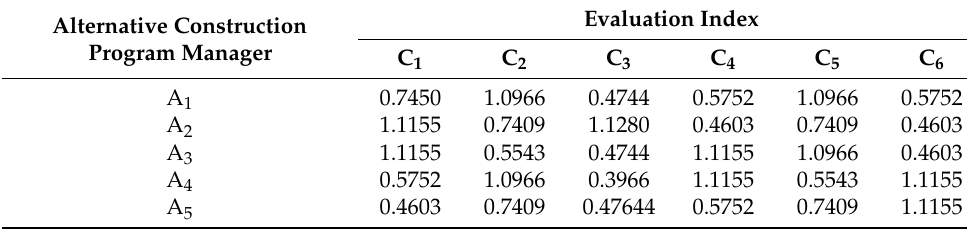
Table 10. Perceived utility value of decision maker D 2 .